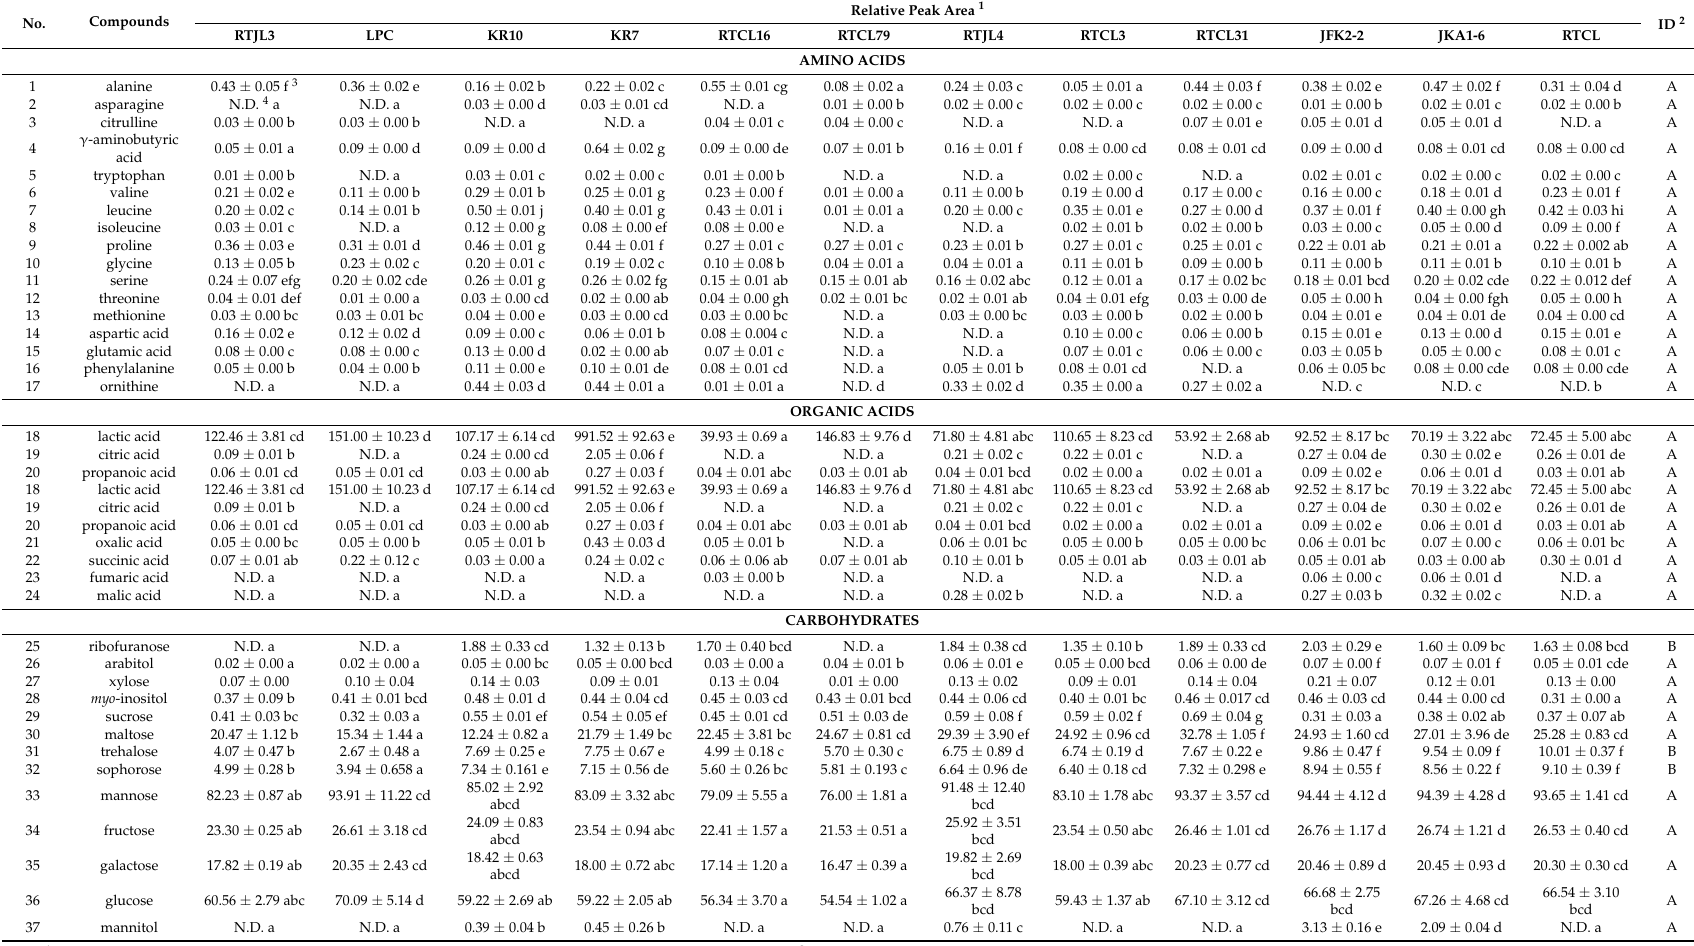
Table 2. Nonvolatile compounds identified in fermented rice according to strains of